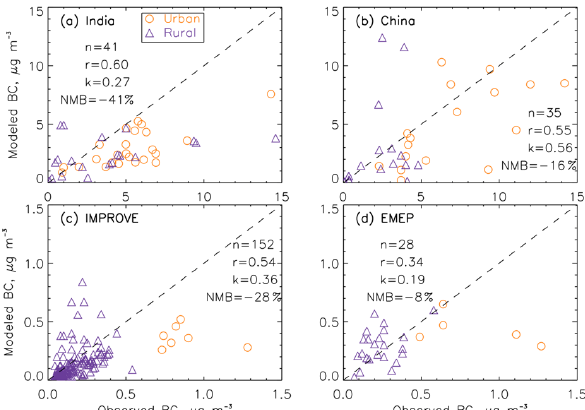
Figure 1. Comparisons of observational and model-simulated an- nual mean surface BC concentrations from (a) India, (b) China, (c) IMPROVE and (d) EMEP. Urban and rural sites are shown by orange circles and blue triangles for each region. For each panel, the total number of observational sites ( n ), model–observation re- gression slopes ( k ), correlation coefficient ( r ) and NMB values are included. The dashed line in each panel represents the 1 : 1